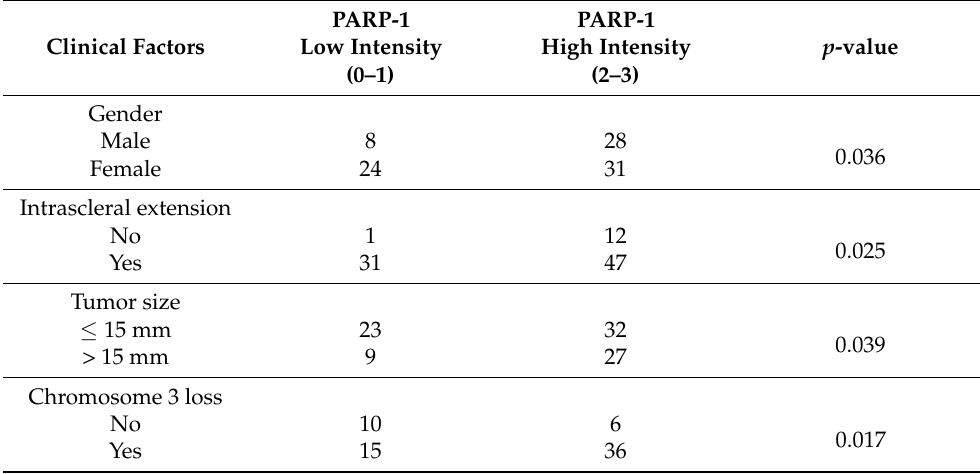
Table 3. Statistically significant correlations of intensity of reaction against PARP-1 with clinicopatho- logical